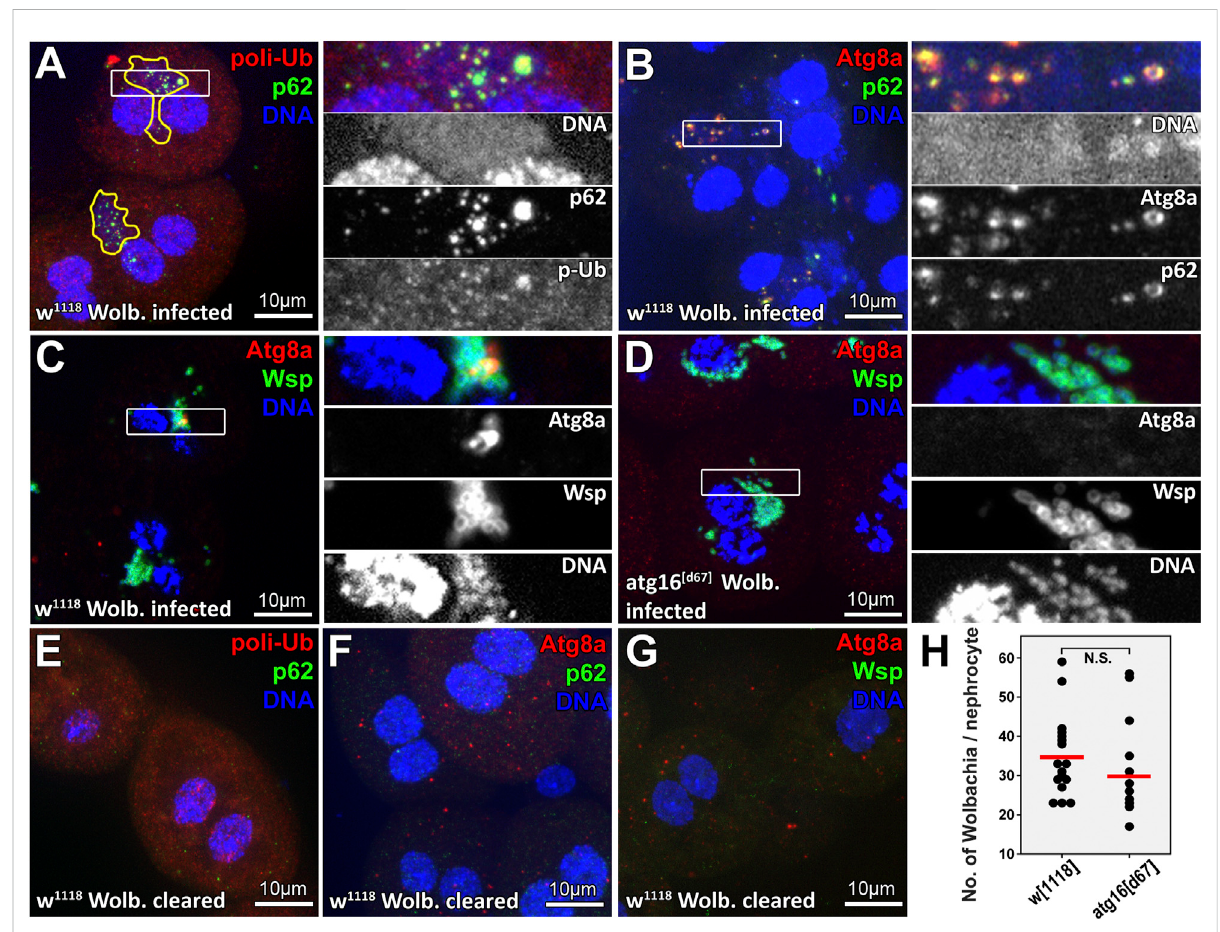
FIGURE 1 A subset of Wolbachia cells colocalize with selective autophagy markers in larval nephrocytes. DNA staining reveals clusters of bacteria (enclosedbyyellowlinesinpanel (A) nearthetwobrighternucleioflarval Drosophila garlandnephrocytes.Withintheseclusters,largepolyubiquitin- p62 or Atg8a-p62 double positive structures can be observed (panels A, B respectively), indicating that some of these bacteria are targeted by selective autophagy. Wolbachia surface protein (Wsp) staining con fi rms the identity of Wolbachia captured within Atg8a positive autophagosomes (C) . No Atg8a positive membranes can be seen in atg16 mutant nephrocytes (D) . Elimination of Wolbachia by rearing animals on tetracycline containing food prevents the appearance of large polyubiquitin-p62 or Atg8a-p62 double positive structures in nephrocytes (E – G) . (H) Quanti fi cation of data in C, (D) n = 30 control ( w 1118 ) and n = 24 atg16[d67] cells (from eight to eight animals), red line indicates median of